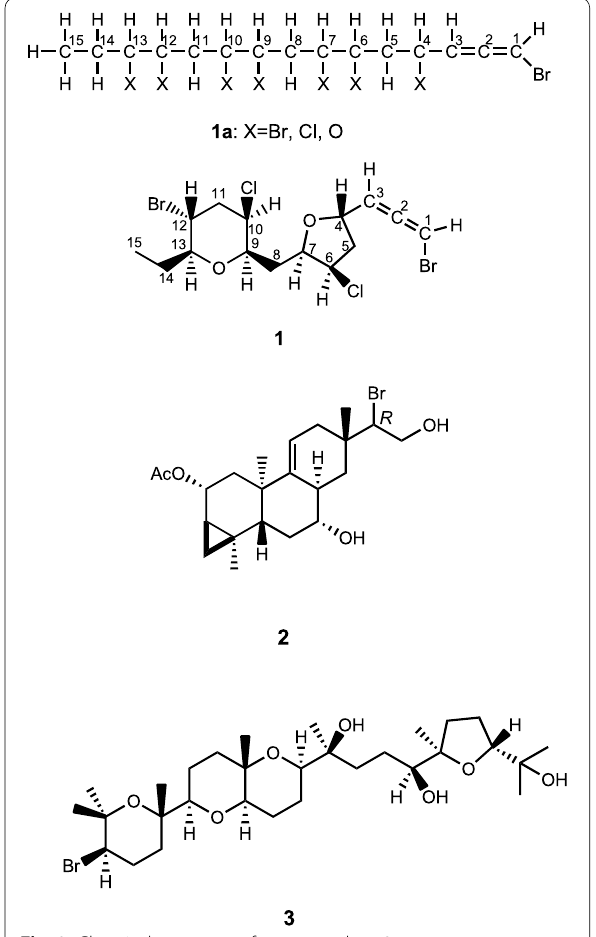
Fig. 2 Chemical structures of compounds 1 – 3